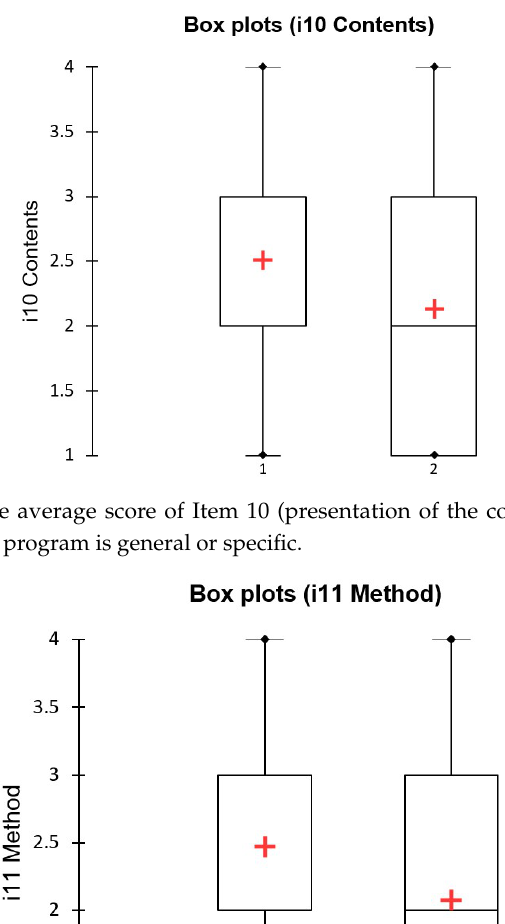
Figure 9. P-values of the Kruskal–Wallis test for items concerning the educational design of the program according to typology of project.